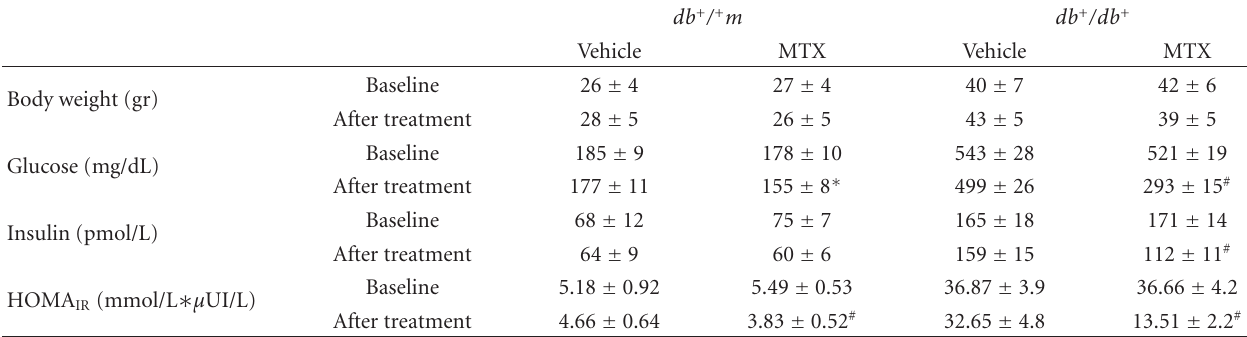
Table 1: Nonfasting glucose and insulin serum levels in genetically diabetic female C57BL/KsJ- m + / + Lept db mice ( db + /db + ) and their normal littermates ( db + / + m ) at baseline and after 4 weeks of treatment with methotrexate (MTX) or vehicle. db + / + m db + /db + Vehicle MTX Vehicle MTX Baseline 26 ± 4 27 ± 4 40 ± 7 42 ± 6 Body weight (gr) After treatment 28 ± 5 26 ± 5 43 ± 5 39 ± 5 Baseline 185 ± 9 178 ± 10 543 ± 28 521 ± 19 Glucose (mg/dL) After treatment 177 ± 11 155 ± 8 ∗ 499 ± 26 293 ± 15 # Baseline 68 ± 12 75 ± 7 165 ± 18 171 ± 14 Insulin (pmol/L) After treatment 64 ± 9 112 ± 11 # Baseline 5.18 ± 0.92 HOMA IR (mmol/L ∗ μ UI/L) After treatment 4.66 ± 0.64 3.83 ± 0.52 # 32.65 ± 4.8 13.51 ± 2.2 # Data are means ± SD. Only significant P are presented. ∗ P < 0.05 versus baseline; # P < 0.001 versus